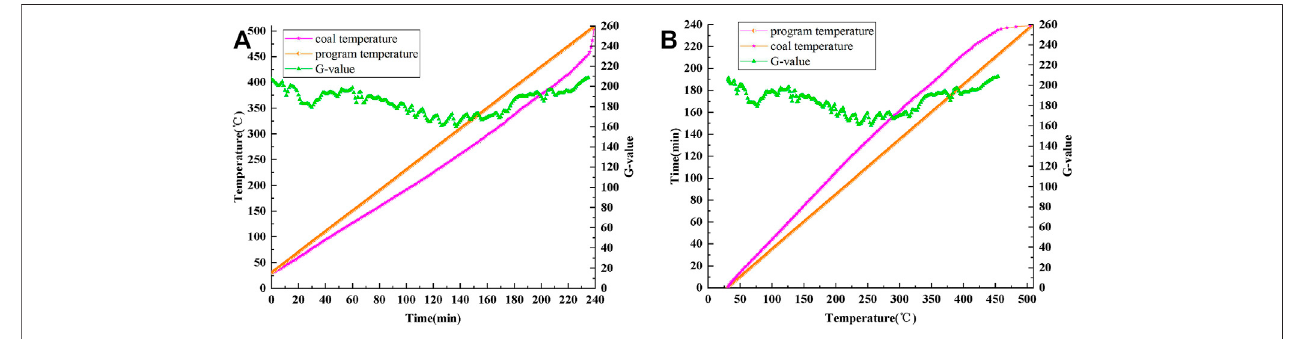
FIGURE 4 | Curves of program temperature, coal temperature and G-value: (A) time-varying, (B) temperature-varying.